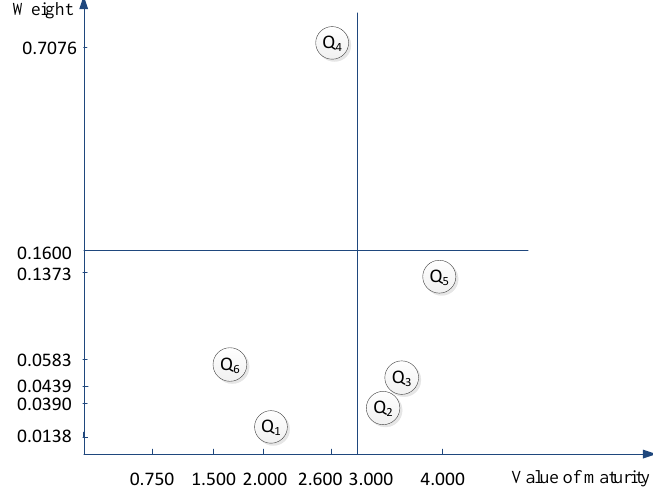
Figure 3. Four quadrants of PaFeng’s Environmental Management Maturity Model of Construction Program (EMMMCP).